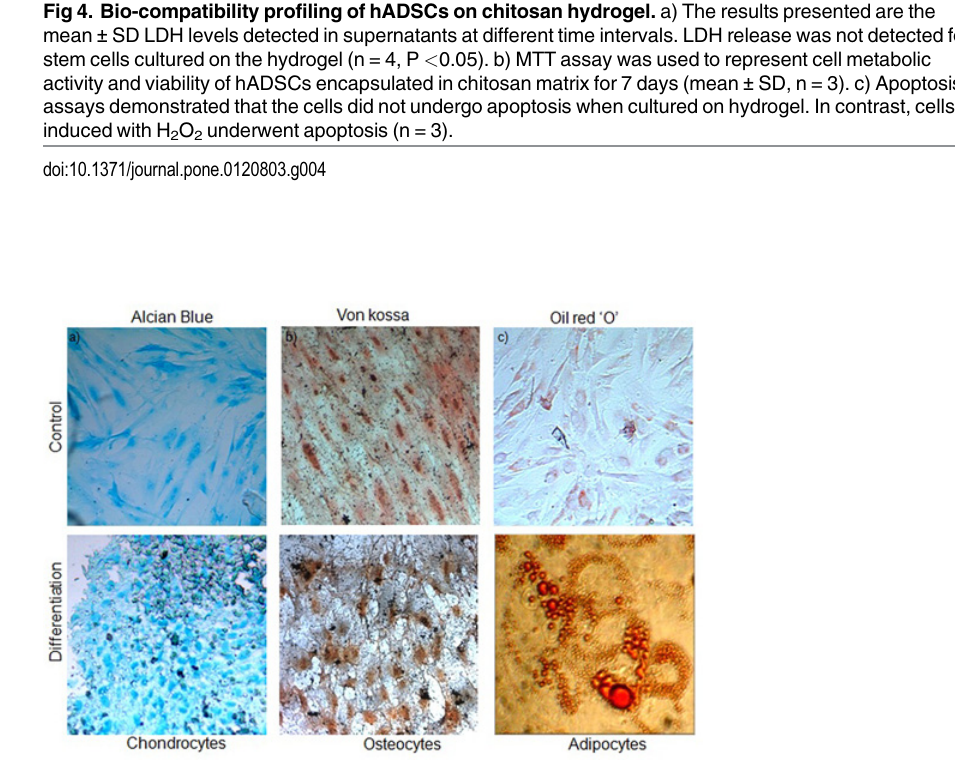
Fig 5. Differentiation potential of hADSCs cultured on a chitosan-based matrix. a) Alcian blue staining of acid mucopolysaccharide aggregates present in the differentiatedchondrocyte cultures grown on chitosan hydrogel. b) Calcium deposits in the ECM were stained using Von kossa staining of the differentiated osteocytes on the hydrogel matrix.c) Lipid droplets were formed on cells laden on matrix after adipogenic induction and werestained with oil red O staining. Negative staining of un-induced cultures for the respectivelineages is also shown. Magnification, 400X (n = 5).